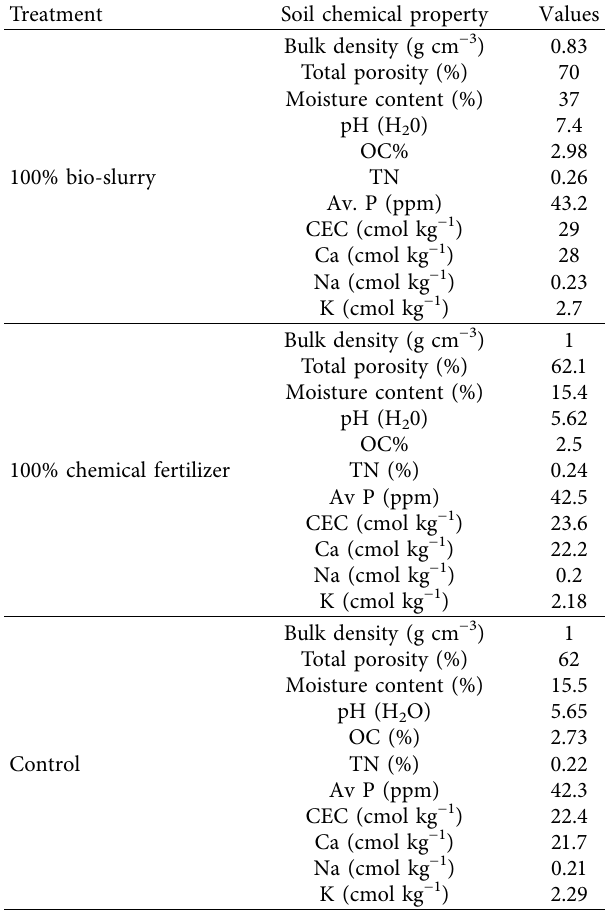
Table 6: Comparison of mean concentration of heavy metals in bio-slurry-treated, chemical fertilizer-treated, and control soil (mg kg − 1 ) (mean ± SD) with